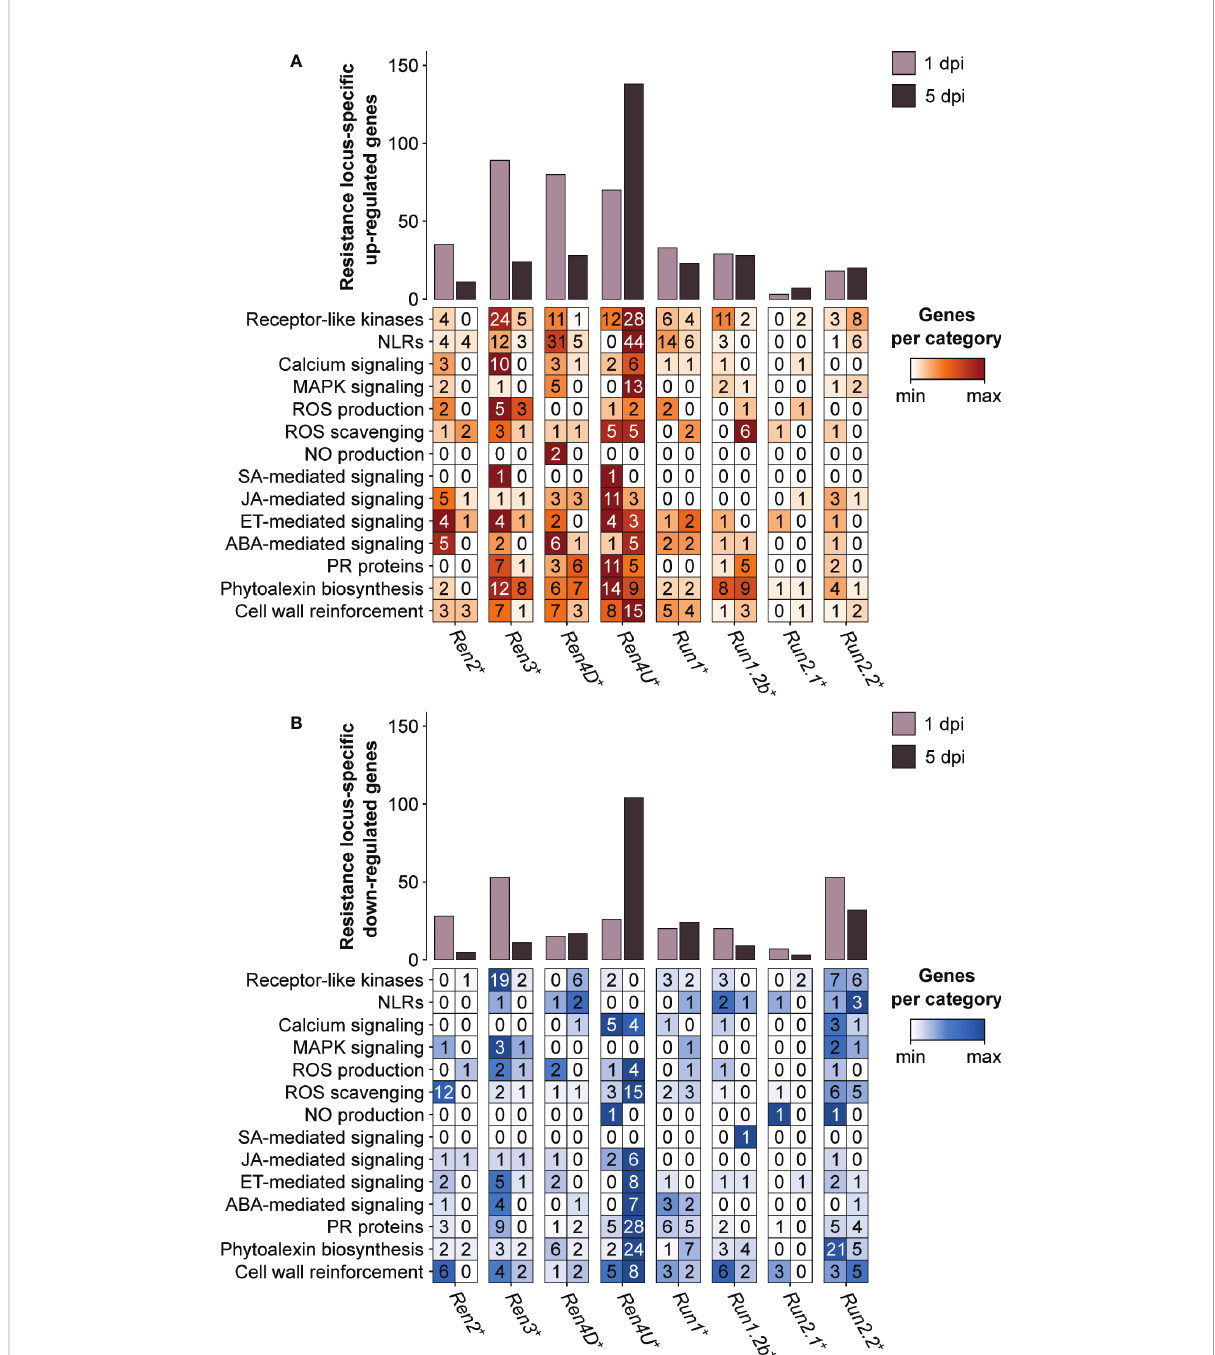
FIGURE 7 Defense-related categories among the genes identi fi ed as up-regulated (A) and down-regulated (B) by only one single PM resistance locus in response to E. necator